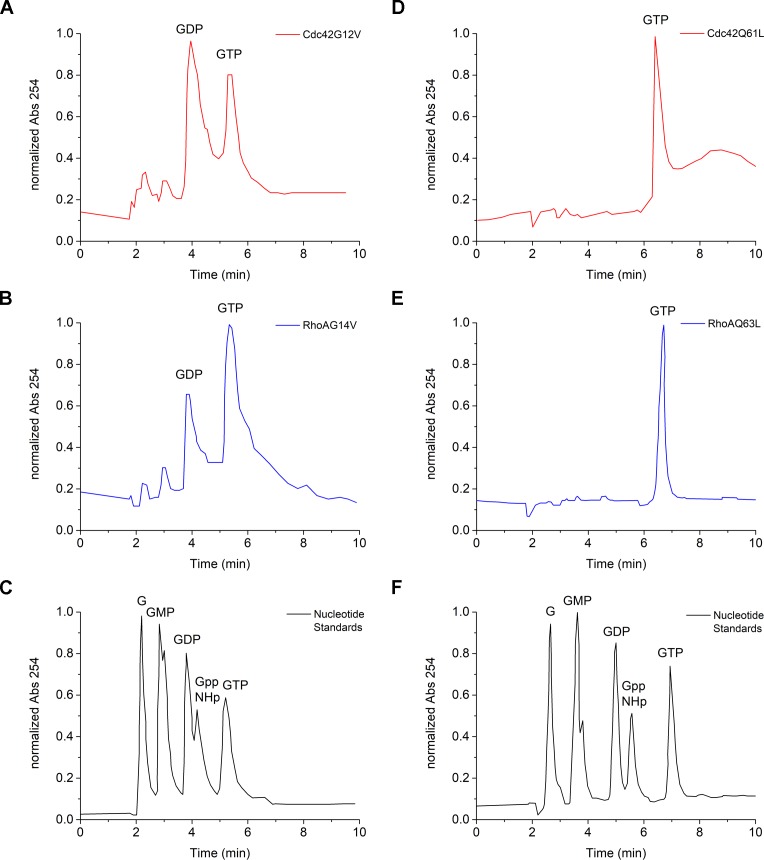
Nucleotide state of constitutively-active RhoGTPase variants after purification.The nucleotide state of Cdc42G12V (A), RhoG14V (B), Cdc42Q61L (D) and RhoQ63L (E) was assessed by reversed phase chromatography monitoring absorbance at 254 nm. A sample containing nucleotide standards was run on the same day of the samples (C for A and B; F for D and E).